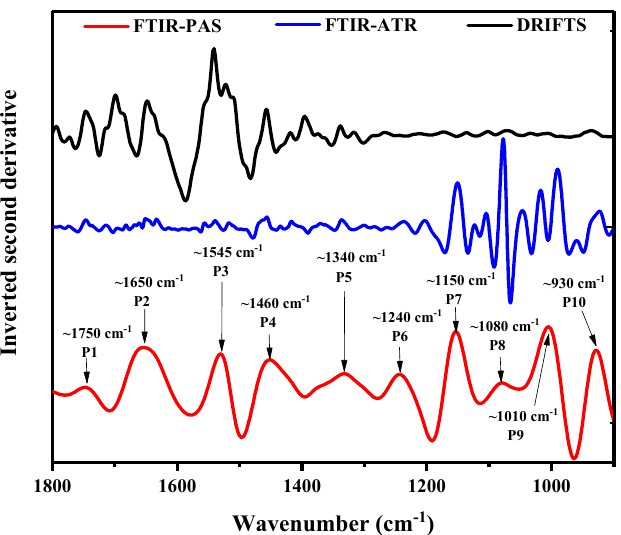
Figure 3. Inverted second-derivative curves of Fourier transform infrared photoacoustic spectroscopy (FTIR-PAS), Fourier transform infrared attenuated total reflectance spectroscopy (FTIR-ATR), and Fourier transform infrared diffuse reflectance spectroscopy (DRIFTS) spectra in the range of 900–1800 cm − 1 .